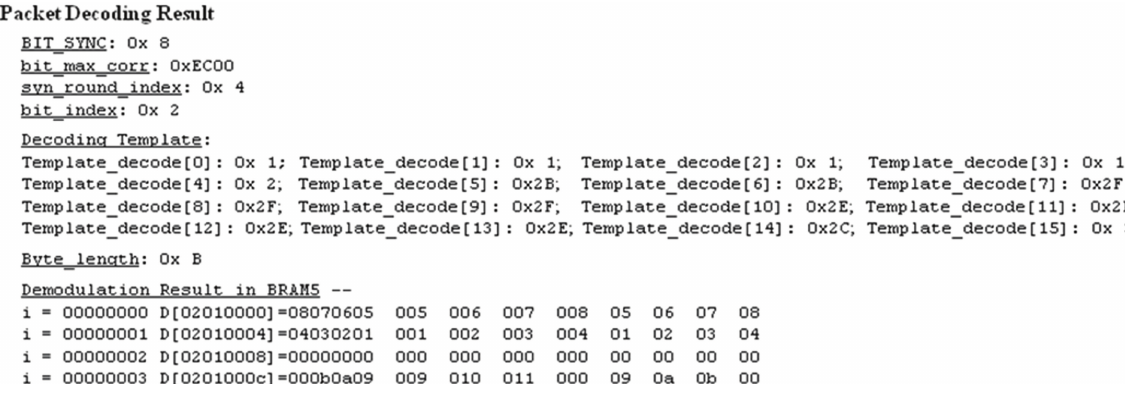
Figure 9: Packet data decoding result printed from